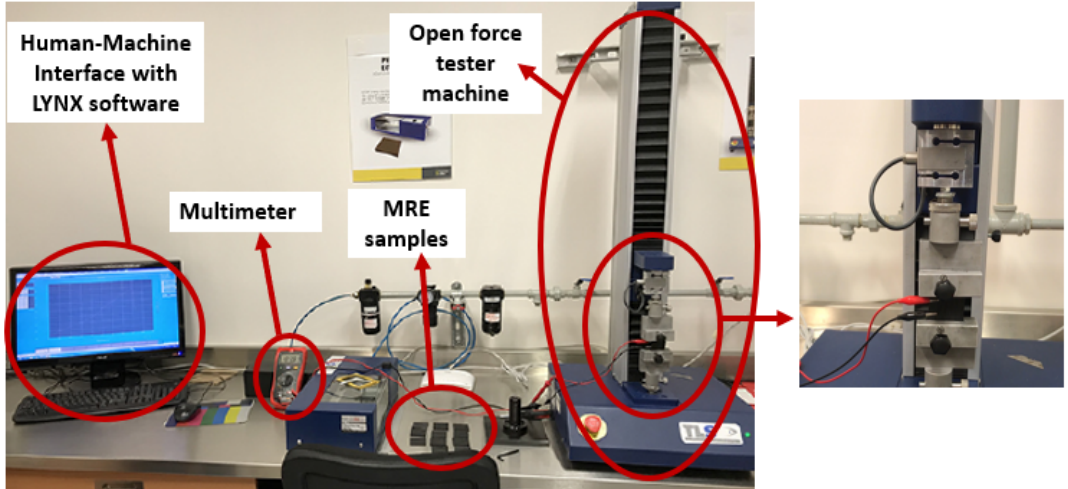
Figure 16. Laboratory setup for MRE tensile